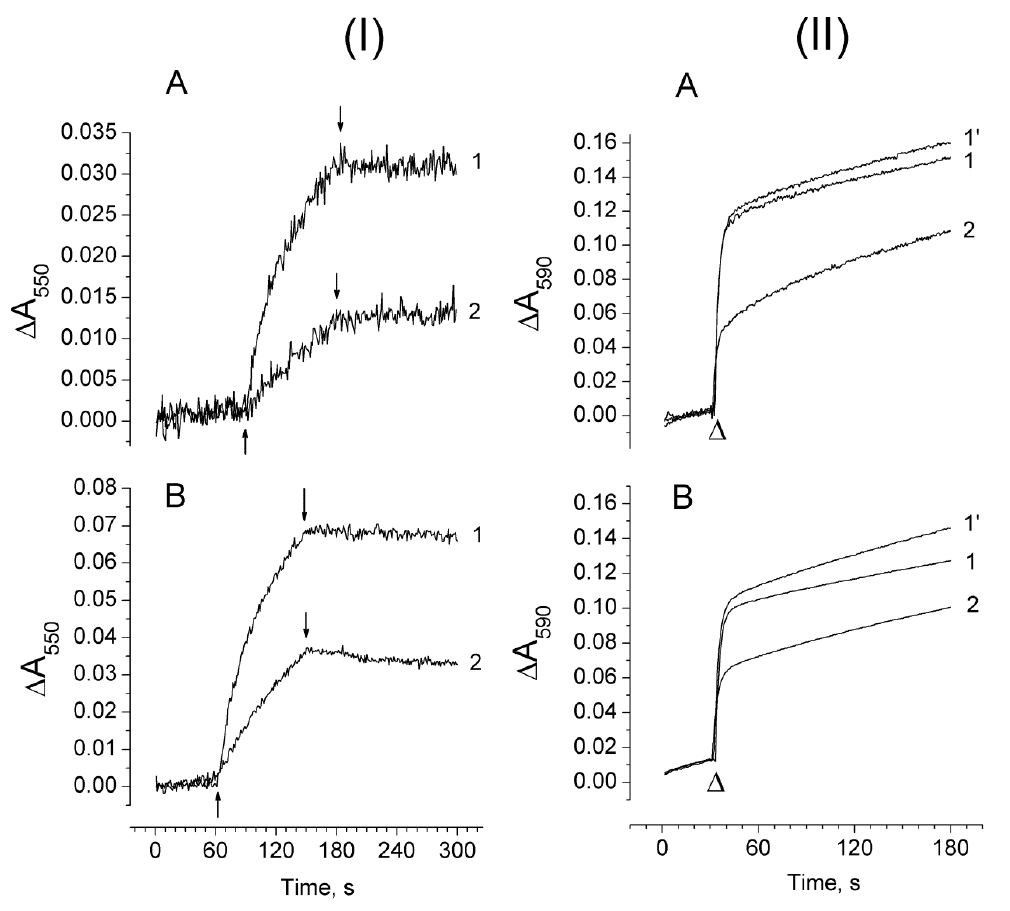
Figure 6. ( I ) Kinetics of Cyt c photoreduction related to the production of O 2 −• in Mn-depleted PSII membranes ( A ) and Mn-depleted PSII core complexes ( B ) in the absence (1) and the presence of 50 µ M DPC (2). ↑ and ↓ light on and o ff , respectively. ( II ) Absorption changes at 590 nm measuring H 2 O 2 production in the Mn-depleted PSII membranes ( A ) and the Mn-depleted PSII core complexes ( B ) after illumination for 90 s ( λ > 600 nm, 1500 µ mol photon s − 1 m − 2 ) in the absence (1) and in the presence of 50 µ M MnCl 2 (2). 1′ –50 µM MnCl 2 was added after the illumination of the samples. Chlorophyll concentration of the PSII membranes and core complexes was 50 µ g Chl / mL and 20 µ g Chl / mL, respectively. The light-induced yield of H 2 O 2 in the samples was measured with 5 mM DMAB, 0.1 mM MBTH, and 3 unit / m1 horseradish peroxidase (HRP) (see Material and Methods). ∆ —injection of HRP into the suspension of the samples.